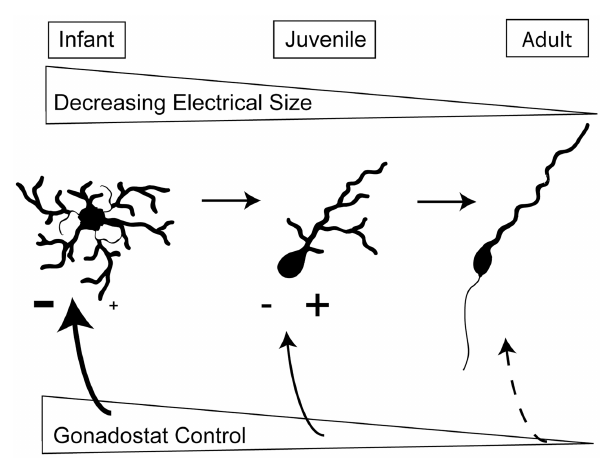
FIGURE 2 | Changes in intrinsic and extrinsic control of GnRH neurons across sexual development . During prepuberty, the larger area of GnRH neurons limits their responsiveness to synaptic input. Additionally, GnRH neurons have fewer spines, the location of excitatory synapses.The stimulation from kisspeptin-containing neurons also appears to be limited. By the juvenile phase of development, the dendritic arbor has decreased, the number of spines has increased, and kisspeptin inputs are likely stimulating GnRH neurons. In adulthood, the final morphology has been achieved and the adult-like synaptic drive is